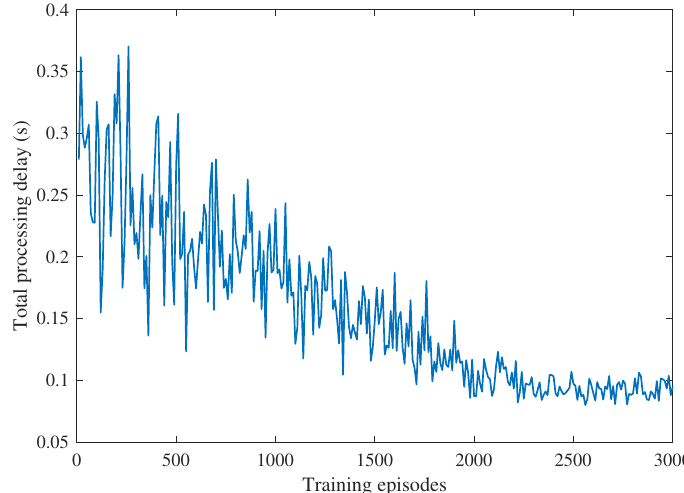
Figure 7. Total processing delay versus the number of training